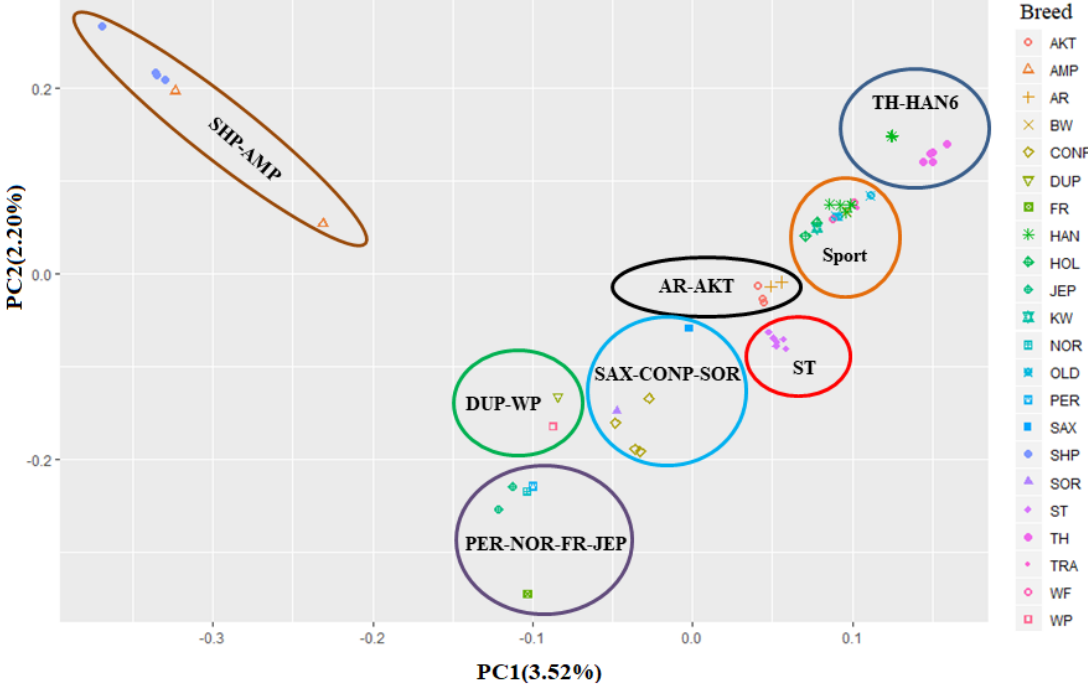
Figure 2. Principle component analysis for sport and non-sport horse breeds. The sport breeds are Baden-Wurttemberg (BW), Dutch warmblood (KW), Hanoverian (HAN), Holstein (HOL), Oldenburg (OLD), Trakehner (TR), and Westphalian (WF). Non-sport breeds are Akhal-Teke (AKT), American Miniature (AMP), Arabian (AR), Connemara pony (CONP), Dülmen pony (DUP), Friesian (FR), Jeju pony (JEP), Noriker (NOR), Percheron (PER), Saxon-Thuringian Heavy Warmblood (SAX), Shetland pony (SHP), Sorraia (SOR), Standardbred (ST), Thoroughbred (TH), and Welsh pony (WP). The PC1 and PC2 are the first two principal components.